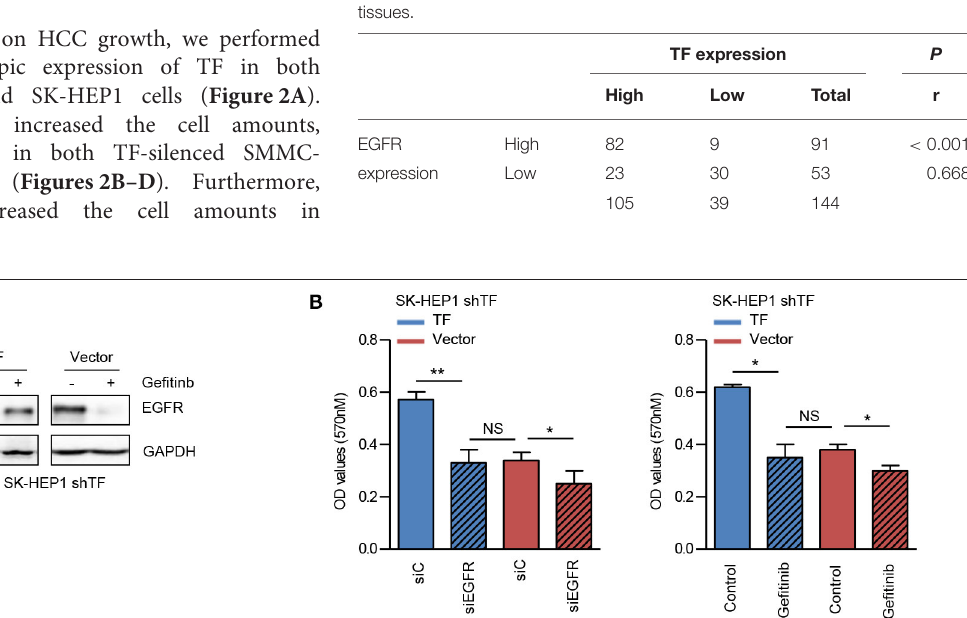
Frontiers in Oncology |